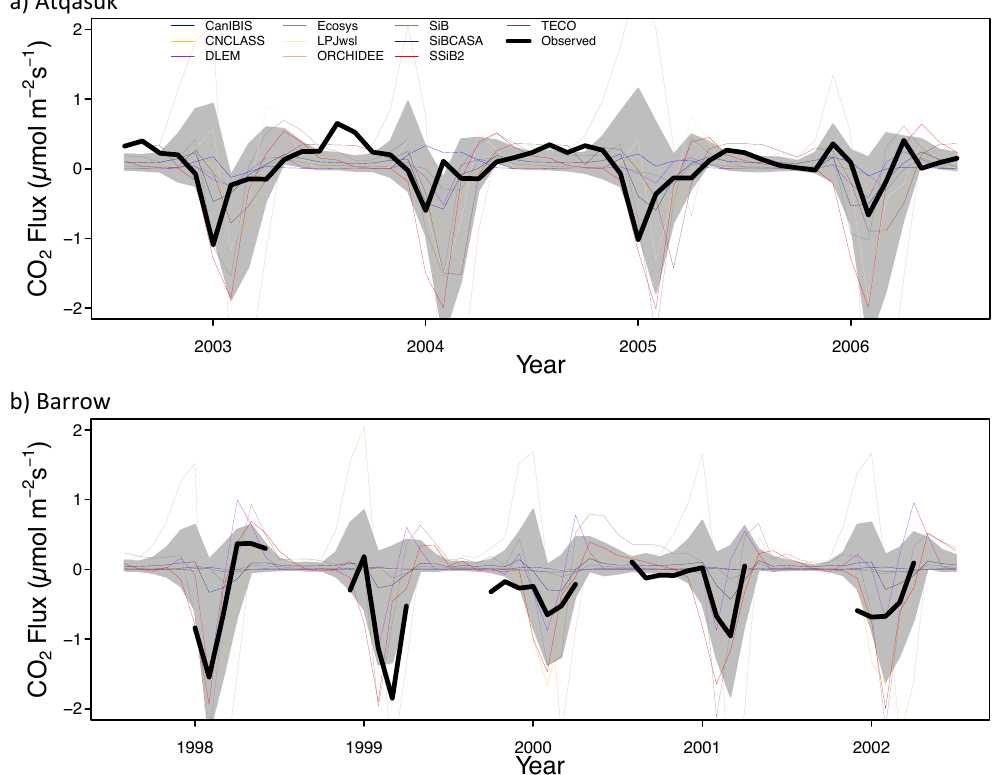
Figure 10. Mean monthly net CO 2 flux for two sites in the Alaskan Arctic: (a) Atqasuk and (b) Barrow. The gray area is the multi-model standard deviation, and the black line is the in situ observed net CO 2 flux.